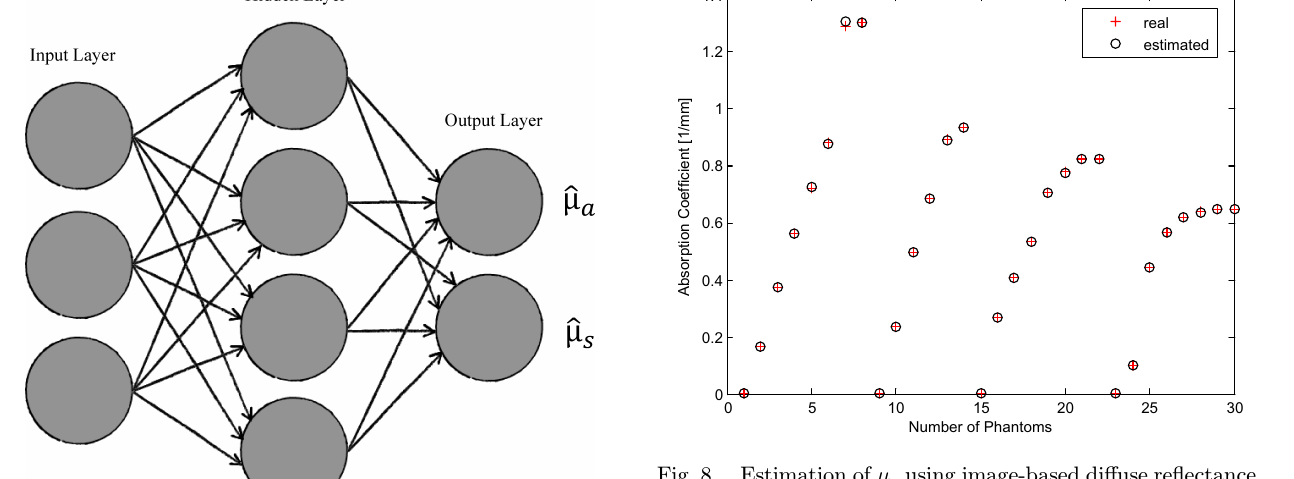
Fig. 8. Estimation of (cid:1) a using image-based di®use re°ectance.